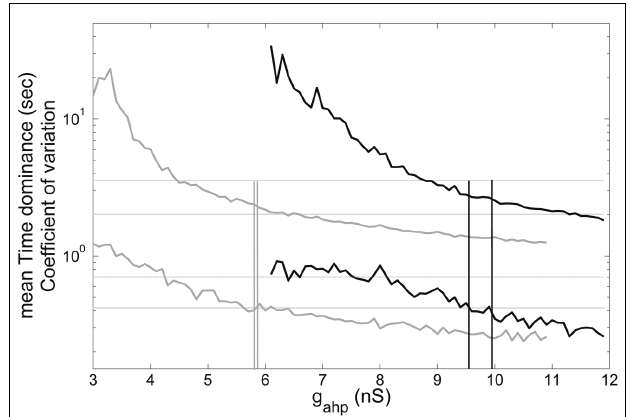
FIGURE 11 | Mean time dominance and coefficient of variation as a function of neuronal adaptation for level of noise n = 0.014, when inhibitory interneurons are adapted (gray lines) and when they are not adapted (black lines) for stimulus strength λ 1 = λ 2 = 50Hz. Gray and black vertical lines define the bifurcation points when inhibitory interneurons are adapted and when they are not,